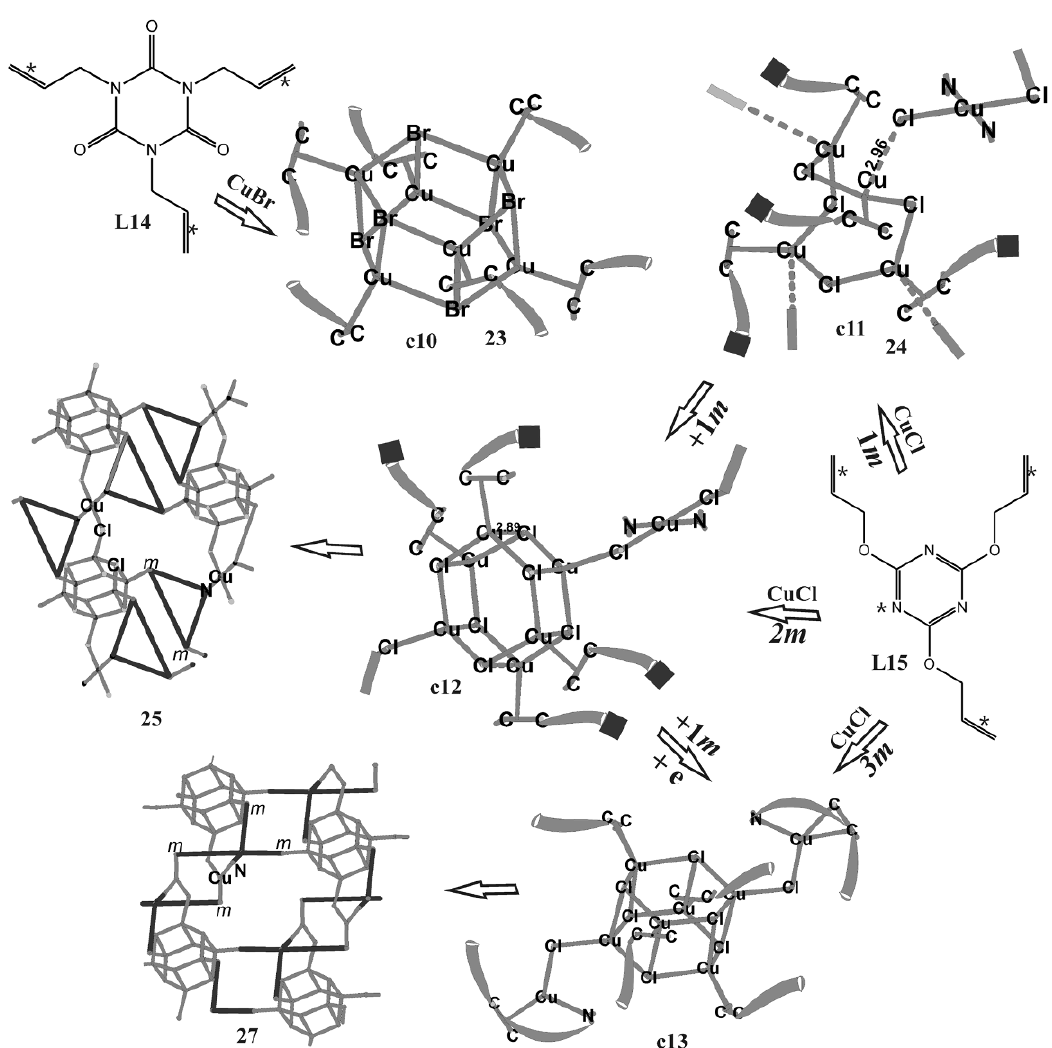
Figure 6. Structural genesis of C10-C13 fragments in 23-27